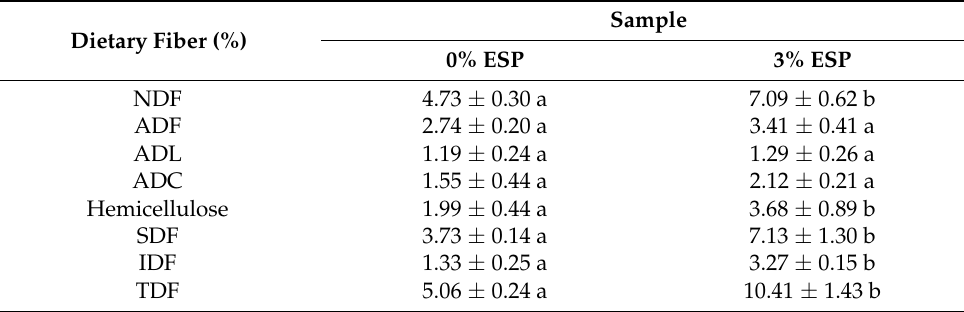
Table 3. Dietary fiber and its fractions contents in fresh gingerbread samples. Dietary Fiber